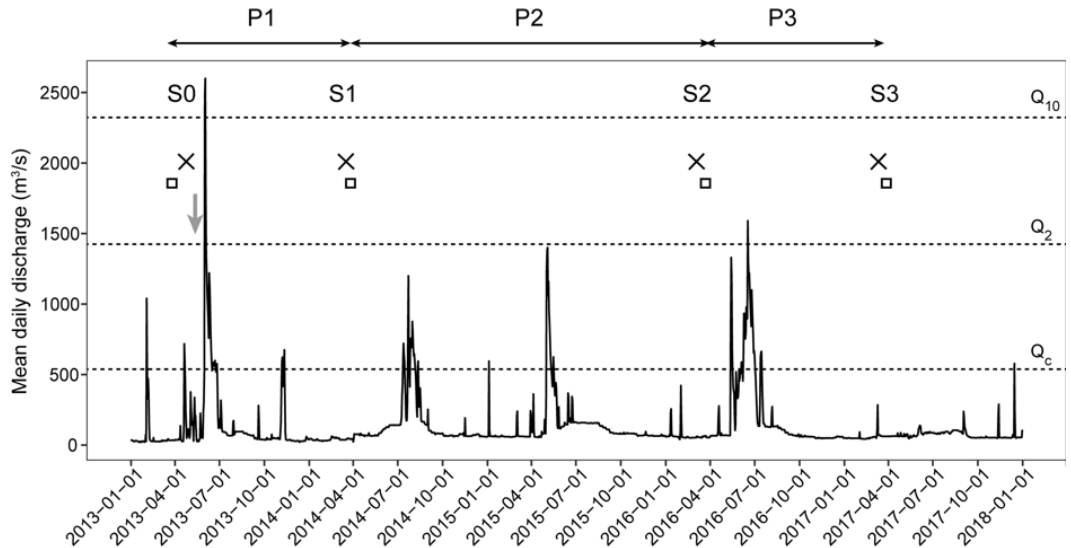
Figure 2. Temporal monitoring framework. Q c corresponds to the critical discharge (550 m 3 .s − 1 ) estimated by [46]. Stars correspond to topo-bathymetric surveys, squares correspond to the collection of physical parameters, and the grey arrow denotes the end of the